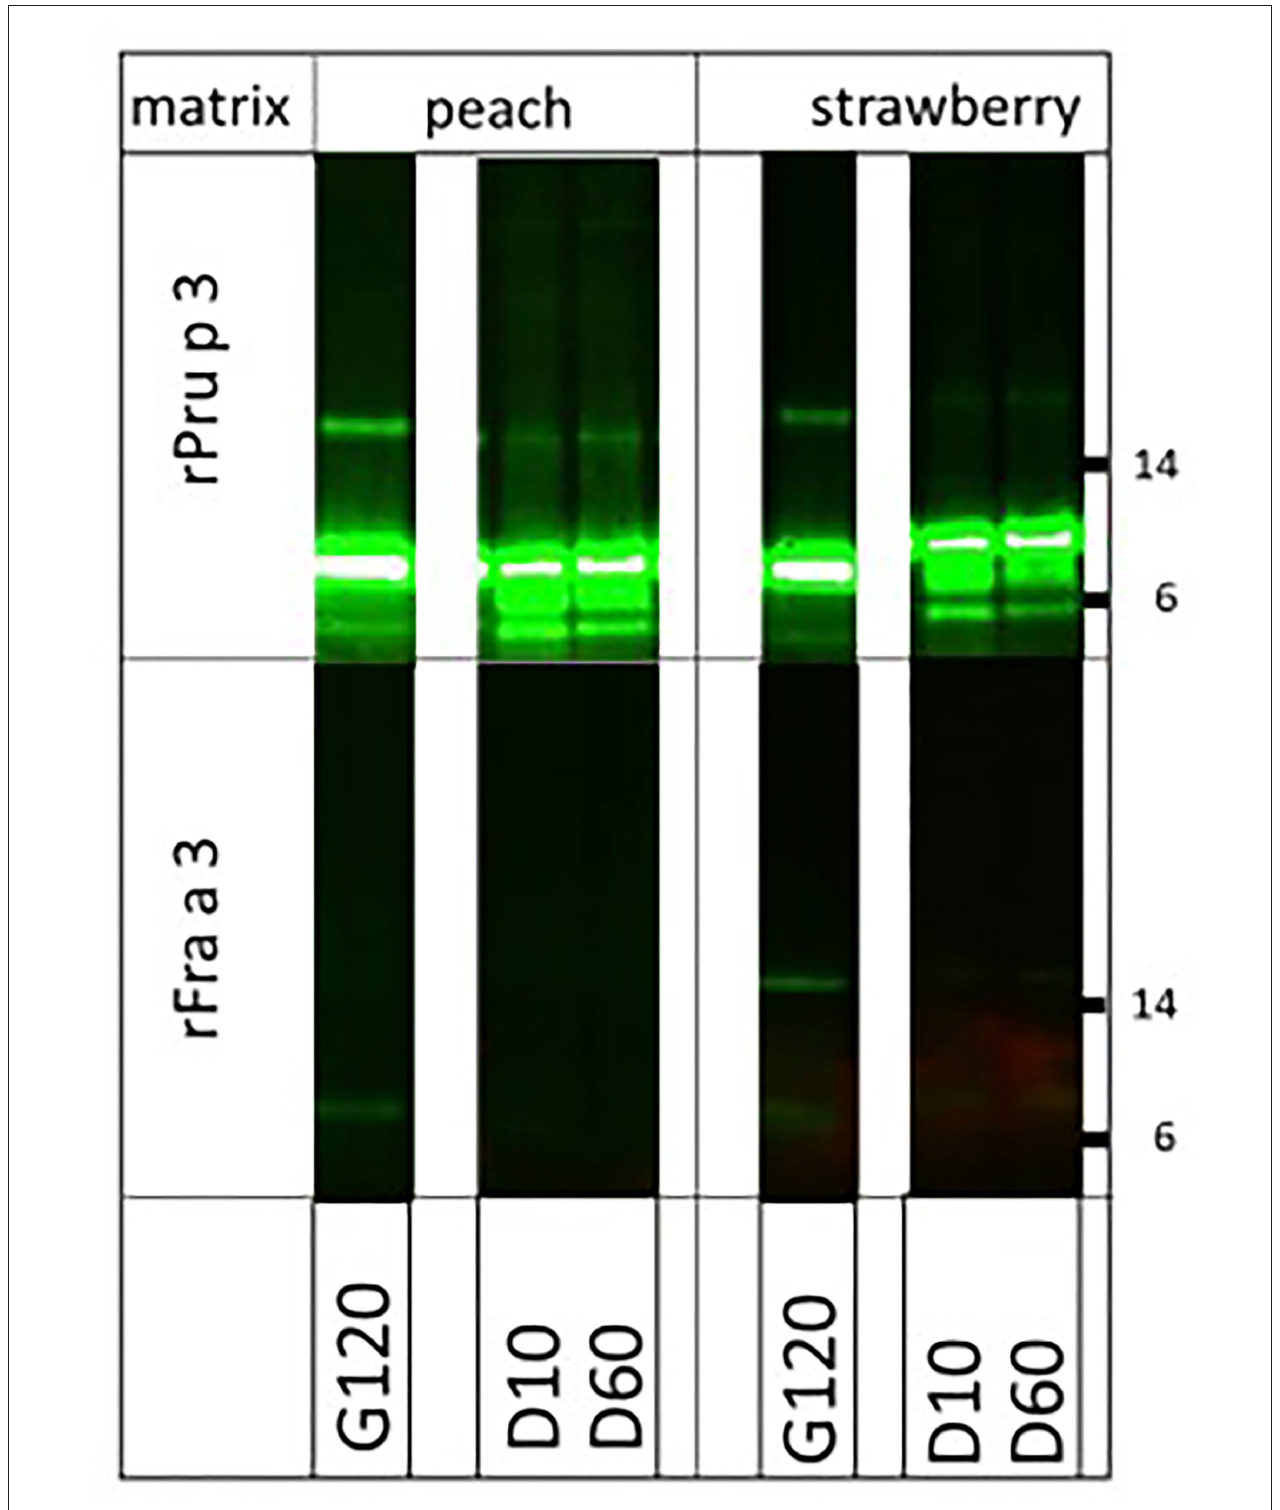
FIGURE 5 | Impact of natural fruit matrices on pancreatin susceptibility of homologous fruit lipid transfer protein (LTPs). Biotinylated recombinant LTPs from peach (rPru p 3) and strawberry (rFra a 3) were spiked into their endogenous fruit matrix and into each other’s fruit matrix. Samples were taken during pancreatin digestion (after 2h pepsin digestion) at G120 ( = D0), and at 10 (G10), and 60 (G60) min of pancreatin digestion. Immunoblot analysis was carried out with labeled streptavidin. Molecular weight markers are indicated on the side in kDa.